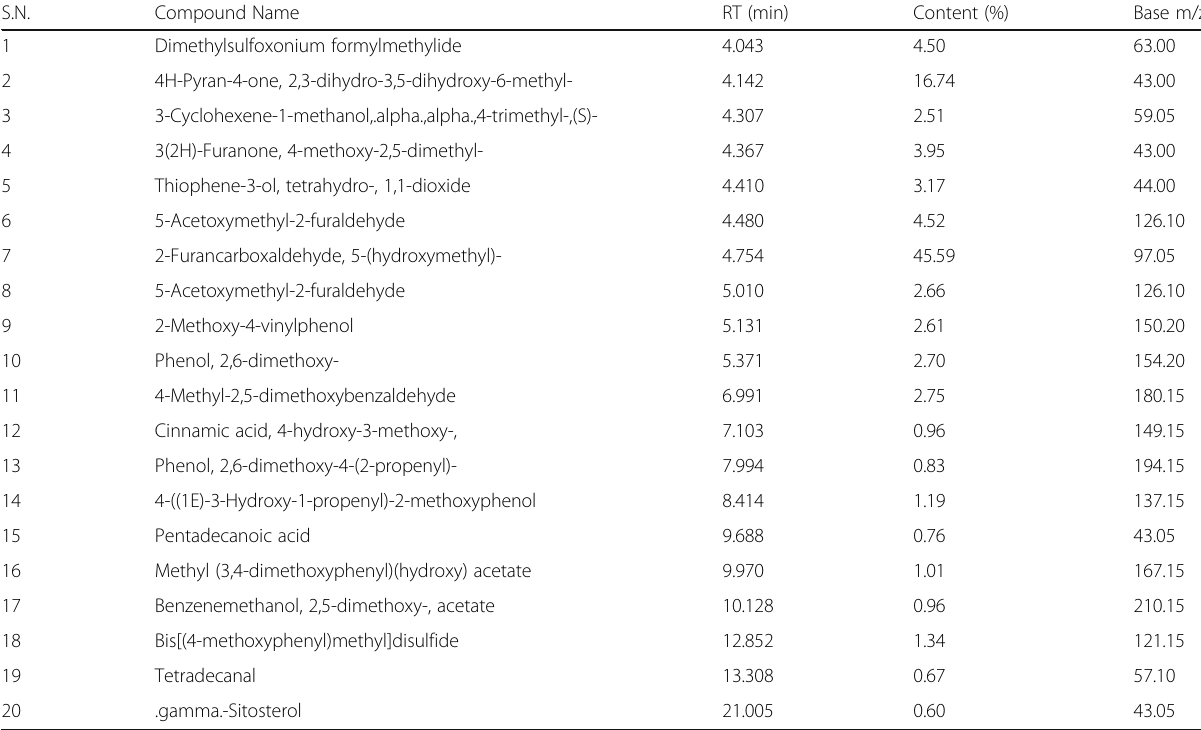
Table 1 Bioactive compounds detected in D. moniliforme ethanol extract (DME)